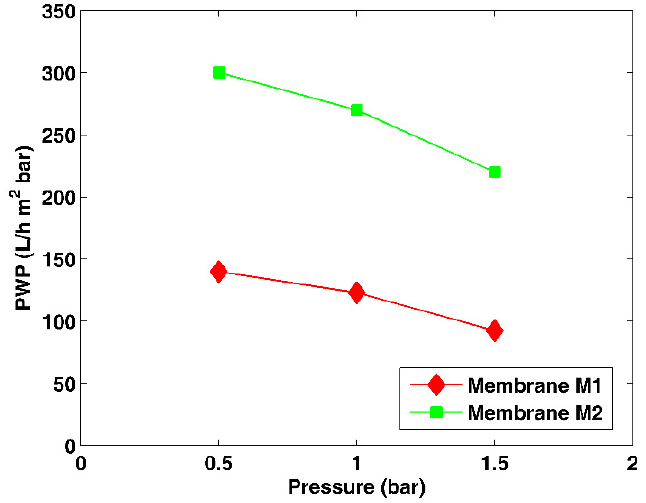
Figure 3. Pure water permeability (PWP) as a function of transmembrane pressure through the membranes M1 and M2.